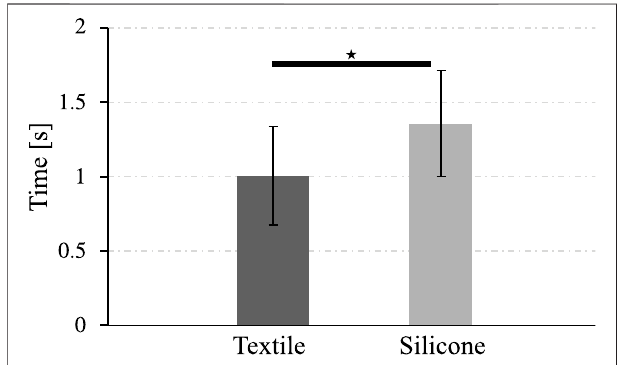
FIGURE9| Timerequiredbytheactuatorstoreachfullbendingposition. The symbol + represents a signi fi cant difference between the two groups based on statistical analysis tests ( p <